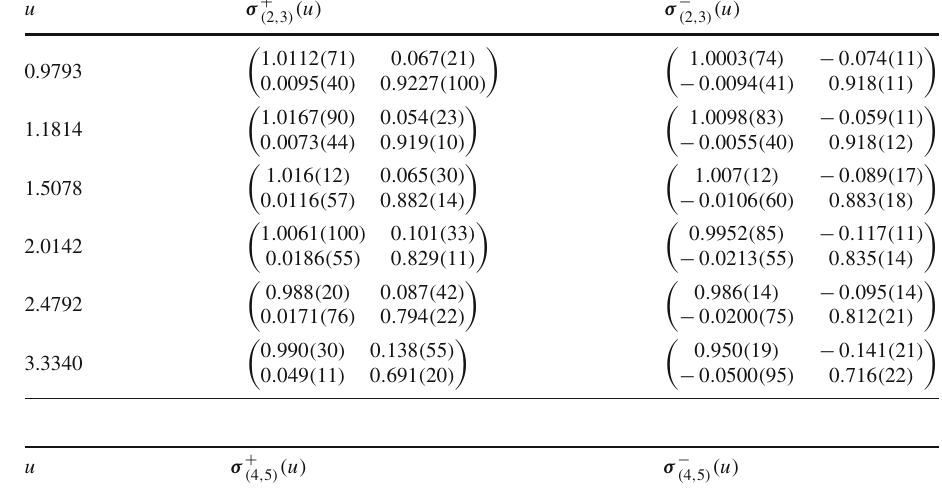
matrix-SSFs for the operator , Q ± bases { Q ± 4 5